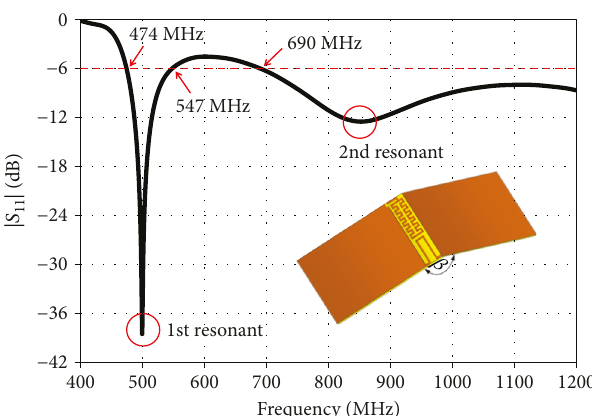
Figure 5: Simulated | S | of the proposed meander line antenna 11 with MD (MD-laden MLA).